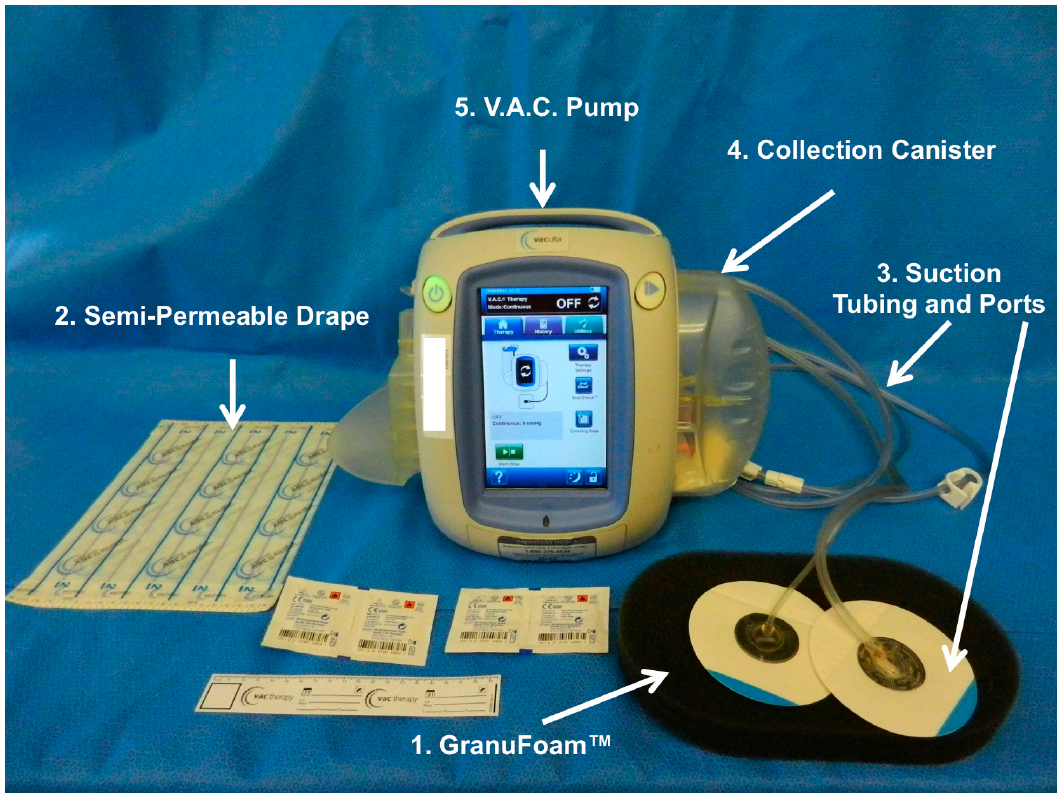
Figure 2. Vacuum Assisted Closure (V.A.C.) system. KCI Veraflow™ is the flagship model, and is designed to provide instillation therapy in addition to standard V.A.C. therapy. The (1) black semi-occlusive dressing (GranuFoam™) along with the (2) semi-permeable drape used to isolate the wound and prevent escape of evaporative moisture. In addition, the (3) suction tubing and suction ports are connected to the (4) collection canister through which (5) the vacuum pump exerts suction force.